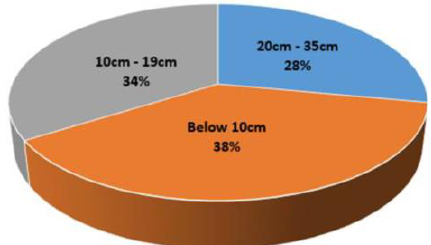
Figure 11. Percentage of trees according to the DBH